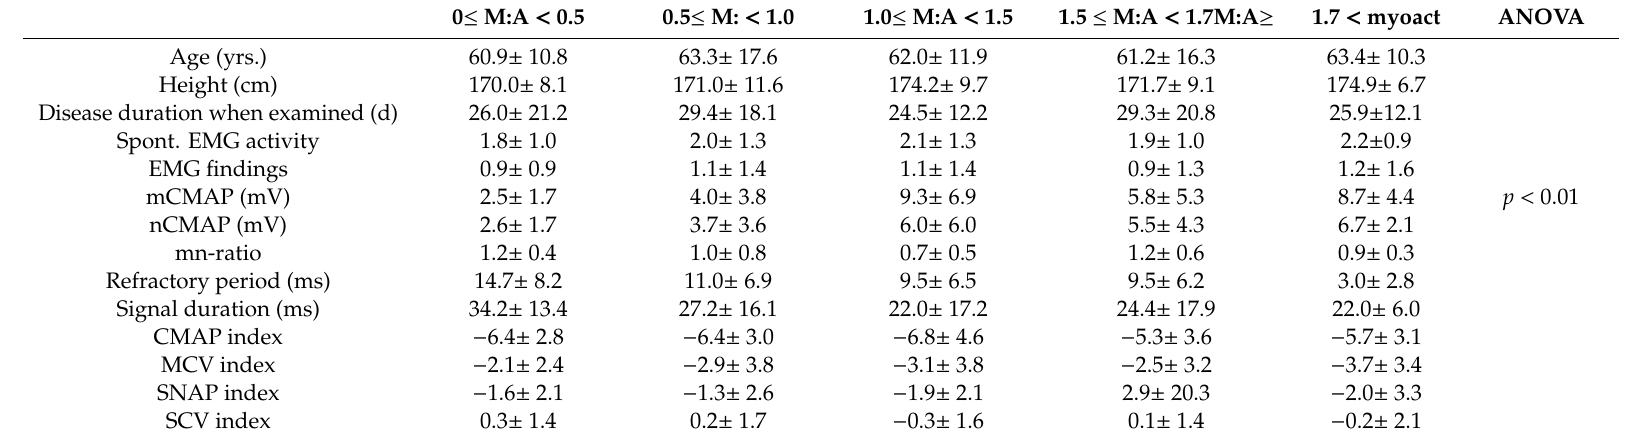
Table 4. Patients were classified into five groups according the preferential myosin loss, i.e., the M:A ratio. Di ff erences in EDX and clinical parameters between the five groups were investigated using a one-way ANOVA. Value are means (or medians when stated) ± SD.